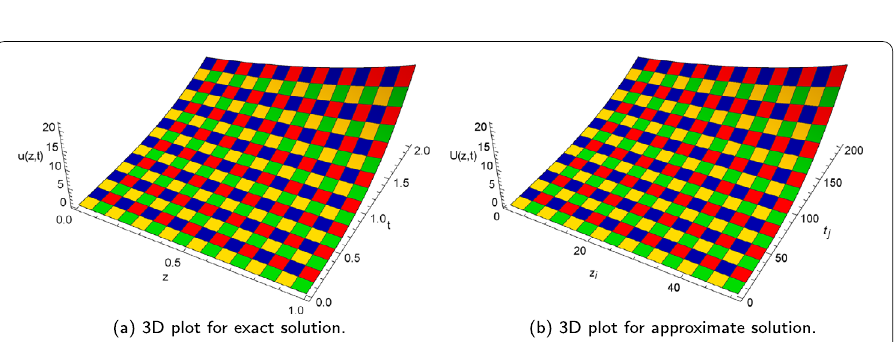
for α = 1.85, t = 1 and (cid:11) t = h 2 . The graphical representation of exact and numerical